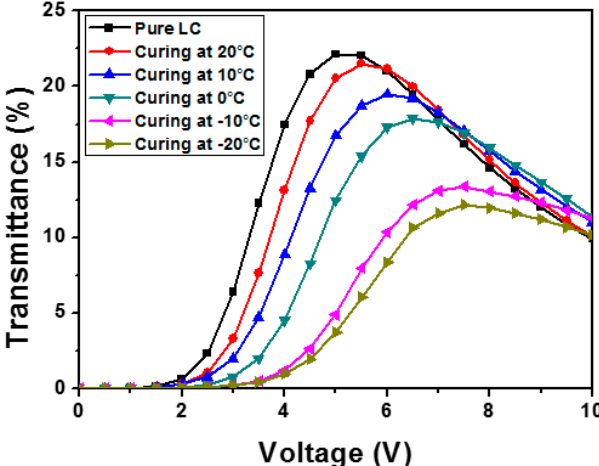
Figure 1. Measured V-T curves of a conventional IPS cell and polymer-stabilized IPS cells cured at 20, 10, 0, − 10, and − 20 °C.